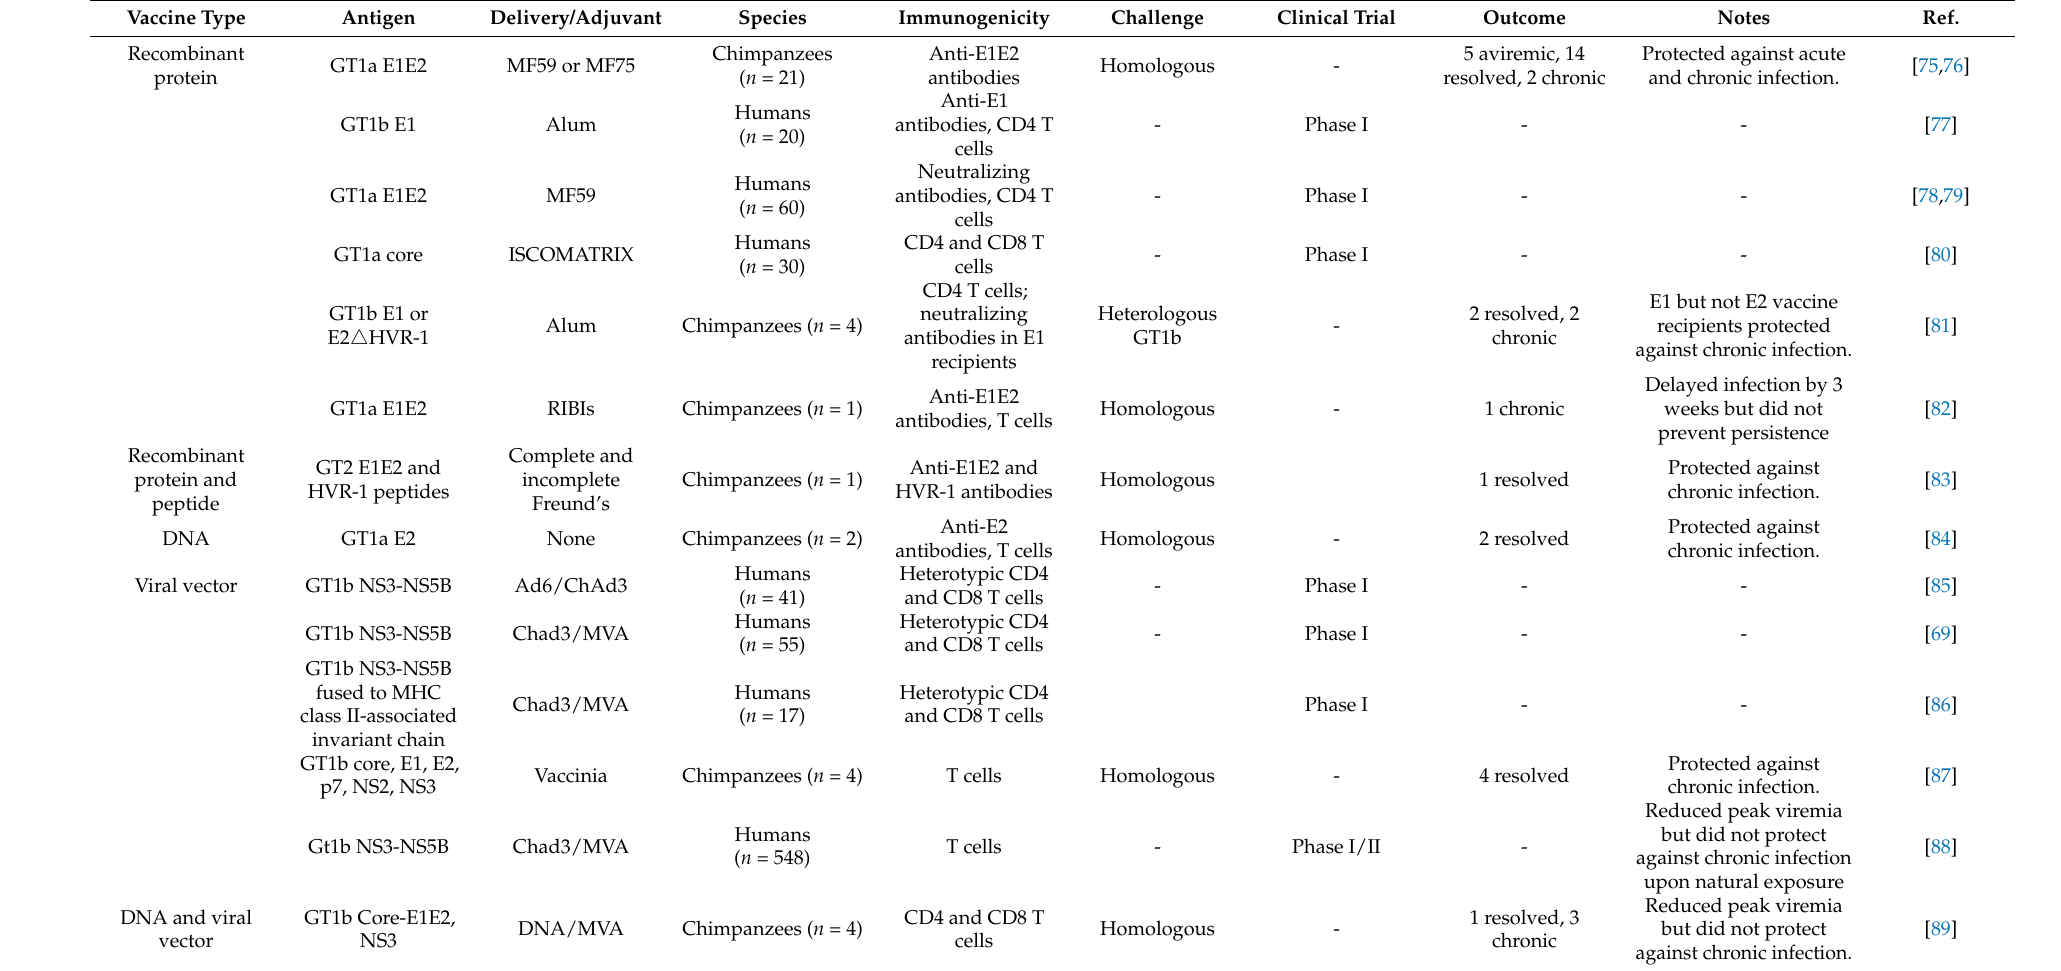
Table 1. Candidate HCV prophylactic